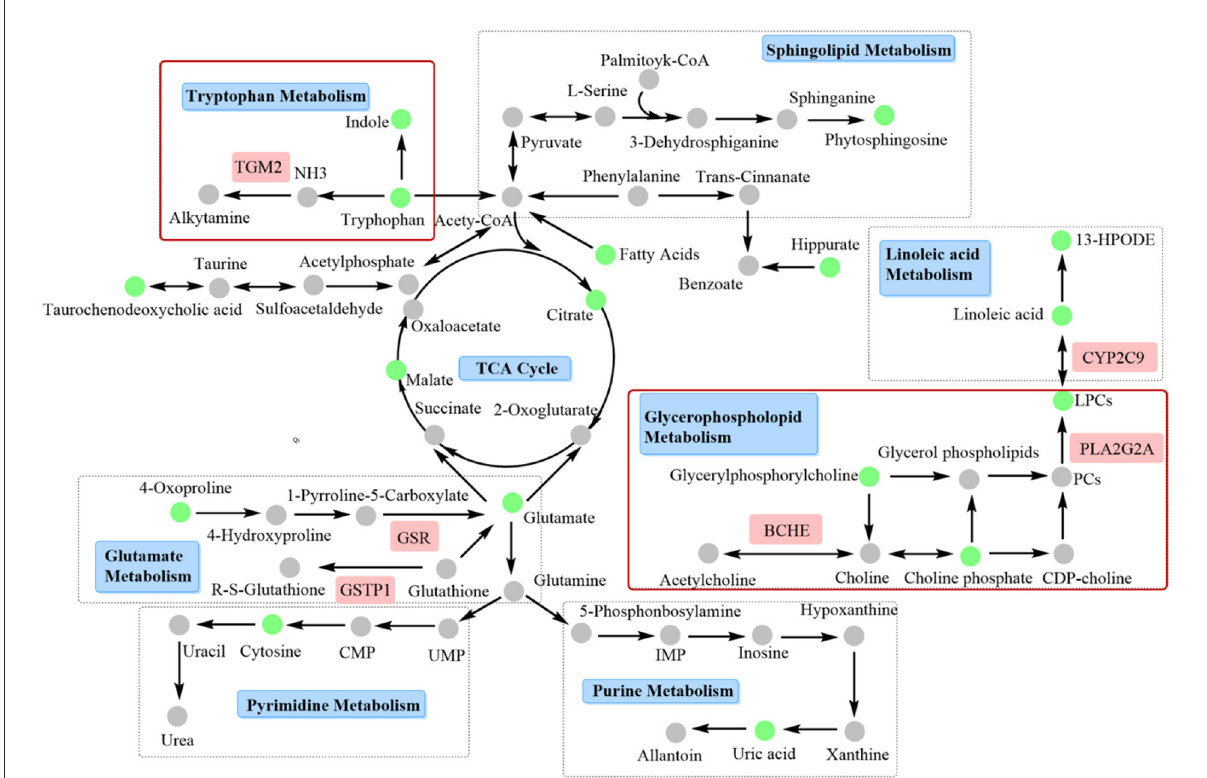
FIGURE6 Interaction network based on metabolomics and network pharmacology. Tryptophan and glycerophospholipid metabolism, and related targets such as TGM2, BCHE, and PLA2G2A should be paid more attention, since these two pathways may be closely related to the clinical efficacy of leonurine against